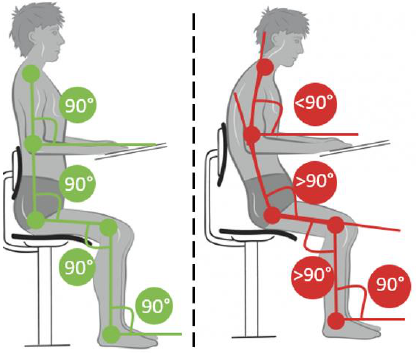
Figure 3. Erect and relaxed sitting position.